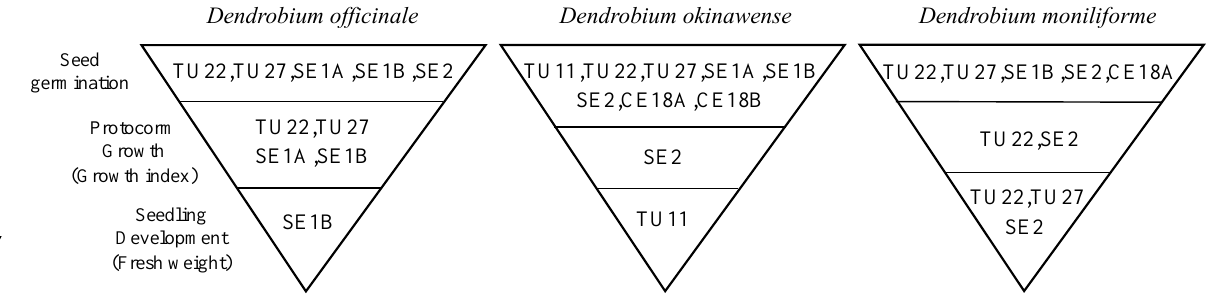
Figure 4. Fungal strains that affect early developmental stages (seed germination, protocorm growth, and seedling development) of Dendrobium officinale , D. okinawense , and D. moniliforme . Fungal isolates that significantly increased seed germination (%) and growth index (GI) values are classified as fungi promoting seed germination and protocorm growth, respectively. For the seedling developmental stage, fungal isolate(s) that significantly increased fresh weight are shown.